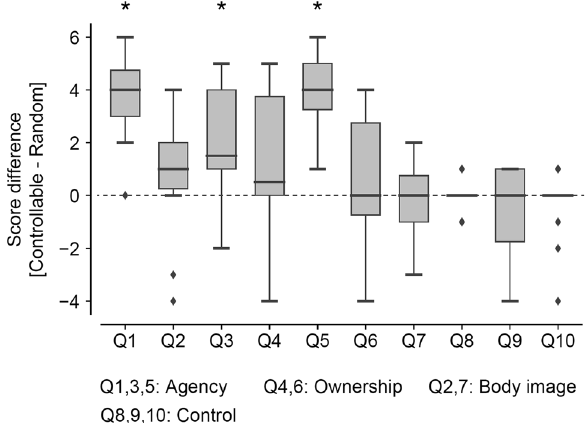
Figure 2. Difference in the subjective questionnaire ratings between the two habituation conditions. The participants answered seven embodiment-related questions and three control questions on a seven-point Likert scale in the controllable and random conditions. The plots show the difference in the rated scores in the two conditions across the participants. In each box plot, the thick line indicates the median, and the bottom and the top lines of the box show the first and the third quartiles, respectively. The whiskers extend to the minimum and maximum points of the data or to the points of 1.5 times the interquartile range if the minimum and maximum points exceed them. The diamond markers showed the data points considered as outliers that exceed the whisker range. Asterisks show statistical significance (FDR-corrected p < 0.05 for multiple comparisons by the Wilcoxon paired signed-rank